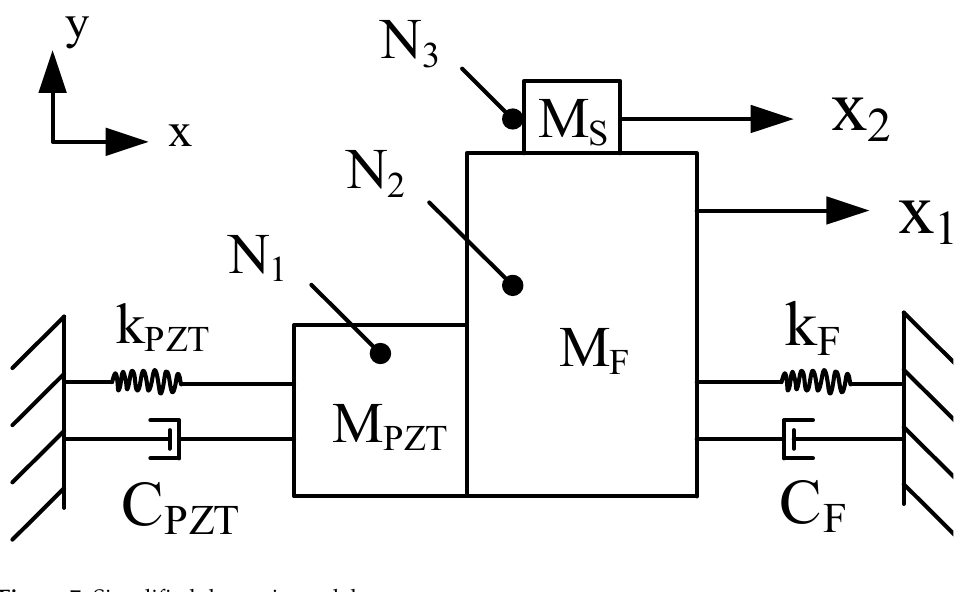
Figure 7. Simplified dynamic model.